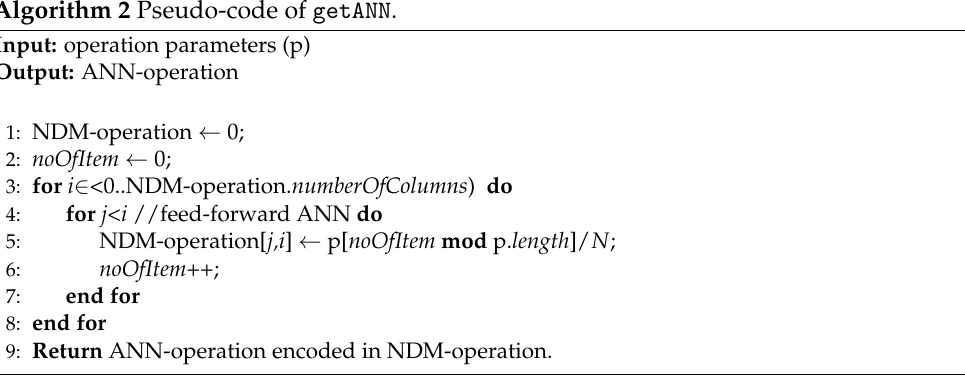
Algorithm 2 Pseudo-code of getANN